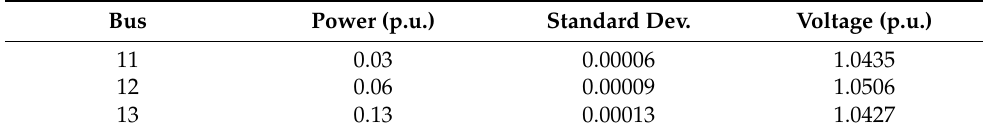
Figure 4. Power flow through lines 4–5 when contingency 3 occurs.